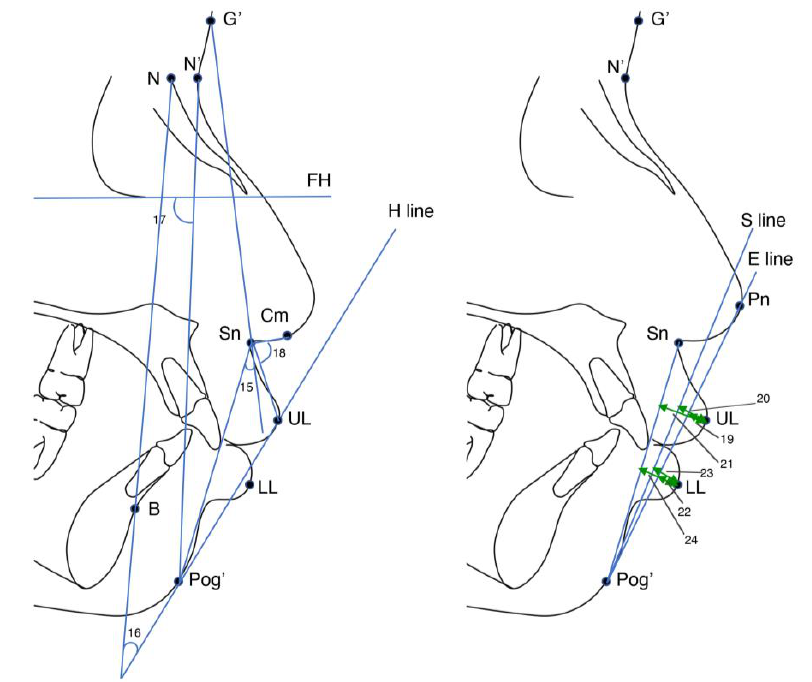
Figure 2. Cephalometric landmarks and soft tissue measurement. G’, soft tissue Glabella; N’, soft tissue Nasion; Pn, Pronasale; Cm, columella; Sn, Subnasale; UL, upper lip anterior; LL, lower lip anterior; Pog’, soft tissue Pogonion; H line, UL-Pog’; E line, Pn-Pog’; S line, middle of the S-shaped curve of nasal- Pog’. Table 1. Definitions of skeletal, dental, and soft tissue measurements.